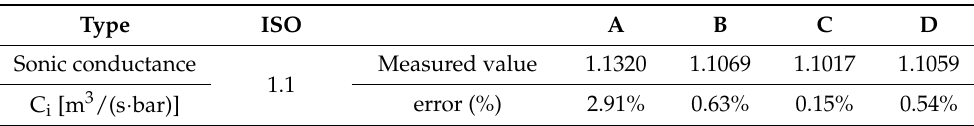
Table 4. Measurement results of sonic conductance of the solenoid valve by isothermal container venting method.